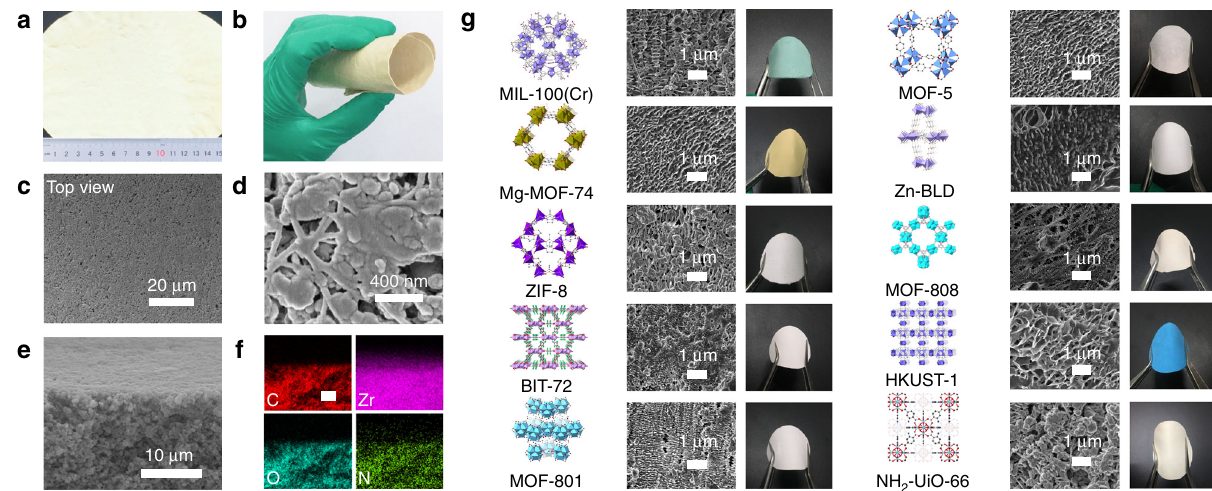
Fig. 2 Ten representative MOF PE MMMs. a , b Photographs of NH 2 -UiO-66 PE MMM-86% with an area of 15 cm × 13 cm. c , d Top view SEM images of NH 2 -UiO-66 PE MMM-86% (scale bar, 20 μ m for c and 400 nm for d ). e , f Cross-section SEM image of the NH 2 -UiO-66 PE MMM-86% and corresponding spatial distribution of C, N, O, and Zr (scale bar, 10 μ m). g Chemical structures of MOF crystals and SEM images and photographs of the corresponding PE MMMs with 86 wt% MOF loading (scale bar, 1 μ